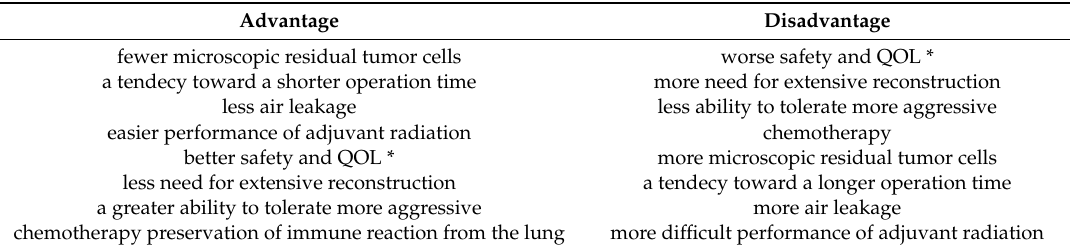
Table 1. Advantages and disadvantages of surgeries for MPM.